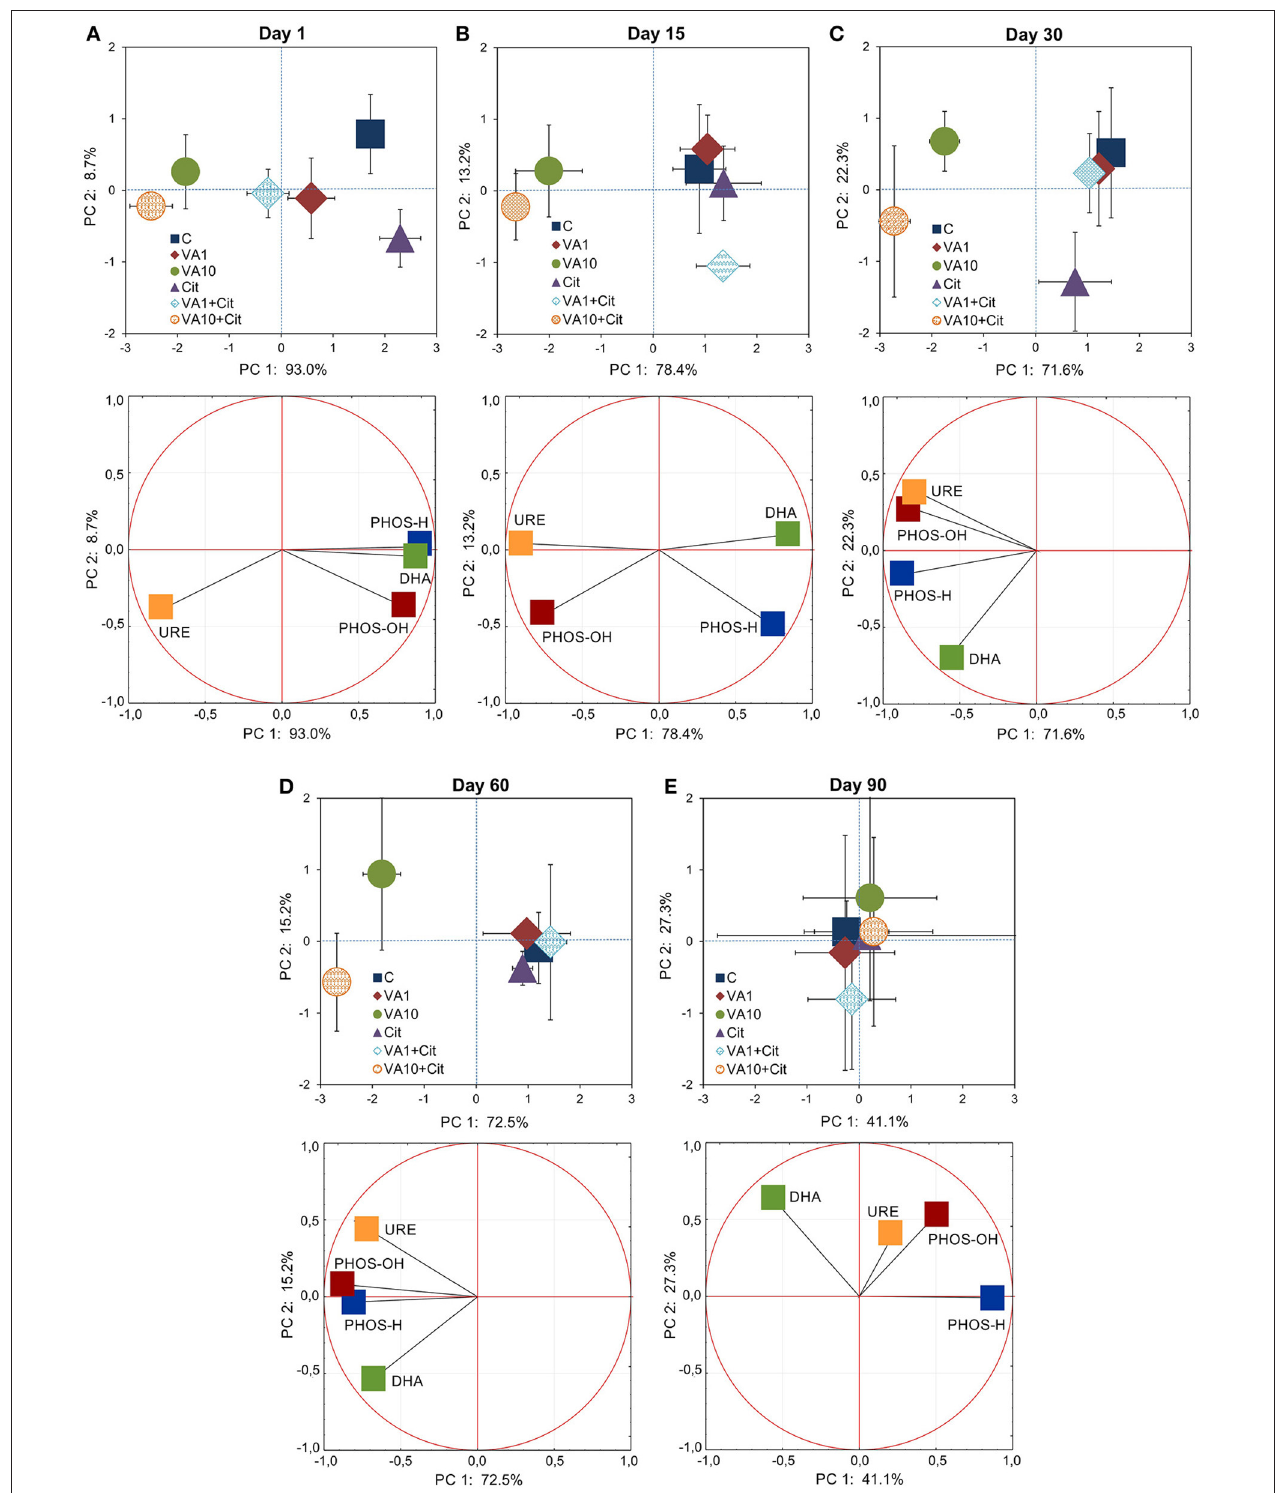
FIGURE 6 | Results of the PCA analysis based on the data of the enzyme activities on days 1 (A) , 15 (B) , 30 (C) , 60 (D) , and 90 (E) . The explanation of the treatment abbreviations is given in Figure 1 .